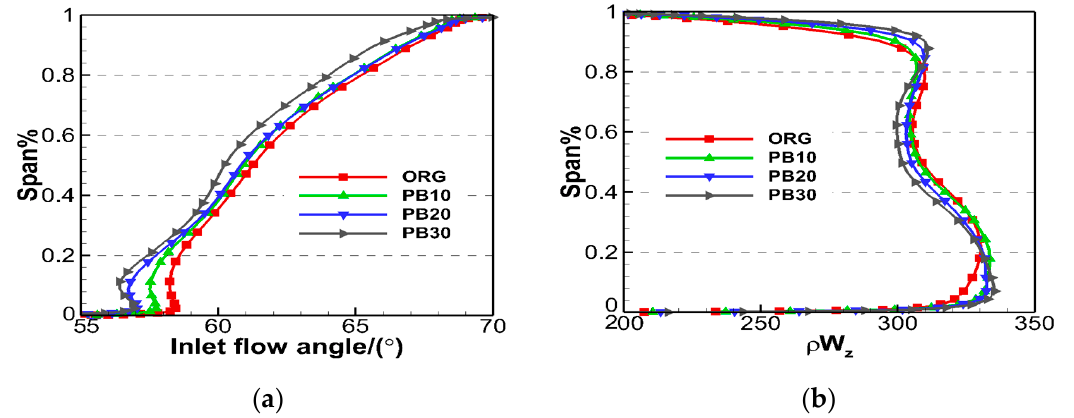
Figure 17. Comparison of spanwise distribution of the inlet flow angle and the axial velocity density (AVD) of PB10, PB20, and PB30. ( a ) the inlet flow angle. ( b ) the axial velocity density (AVD).